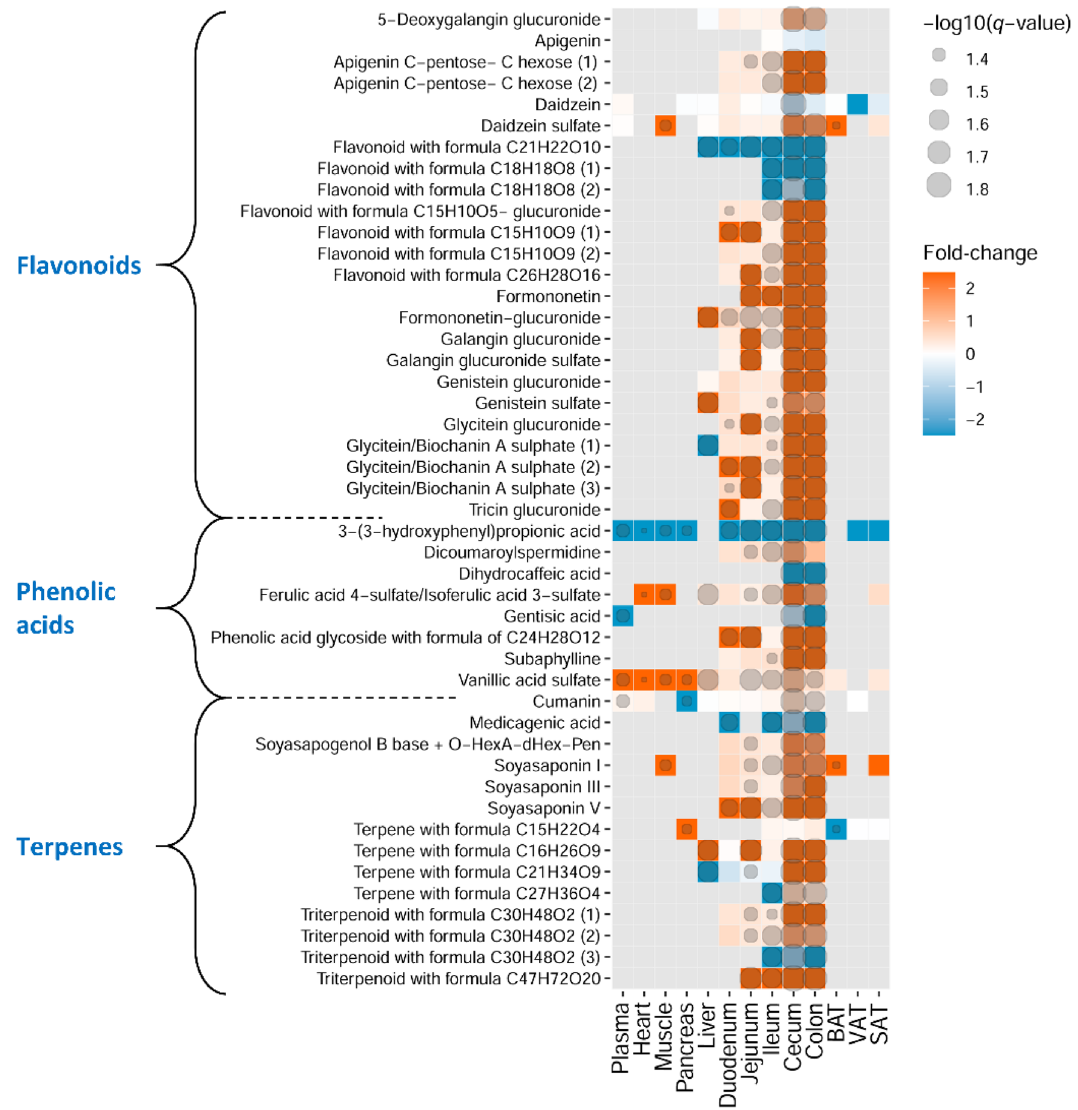
Figure 8. Heatmap representation of identified metabolites in phenolic acid derivatives, flavonoids, and terpenes. Fold-change (GF vs. MPF) and degree of significance comparisons were performed between the GF and MPF within each tissue (Mann–Whitney U-test and Benjamini and Hochberg false discovery rate correction p value ≤ 0.05, and q value ≤ 0.05). Each comparison for a tissue is represented by a colored cell. Gray cells represent metabolites that were not found in the tissue. Orange and blue cells represent metabolites more abundant in GF and MPF mice,